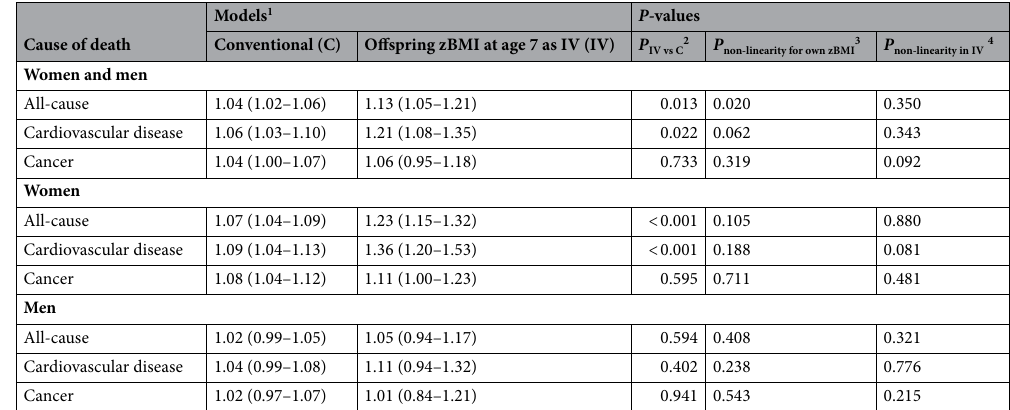
Table 2. Associations between zBMI at age 7 and adult mortality: hazard ratios (95% confidence intervals) per zBMI estimated from conventional analyses of own zBMI and from analyses using offspring zBMI at age 7 as instrumental variable (IV). 1 Adjusted for offspring and parental birth cohort, parental and offspring zheight and parental sex. 2 P -values from Durbin-Wu-Hausman test. 3 P -values from a Wald test of non-linearity in the conventional association. 4 Linear trend test from a meta-regression of stratum specific IV estimates on the stratum-specific mean zBMI. BMI body mass index, IV instrumental variable.